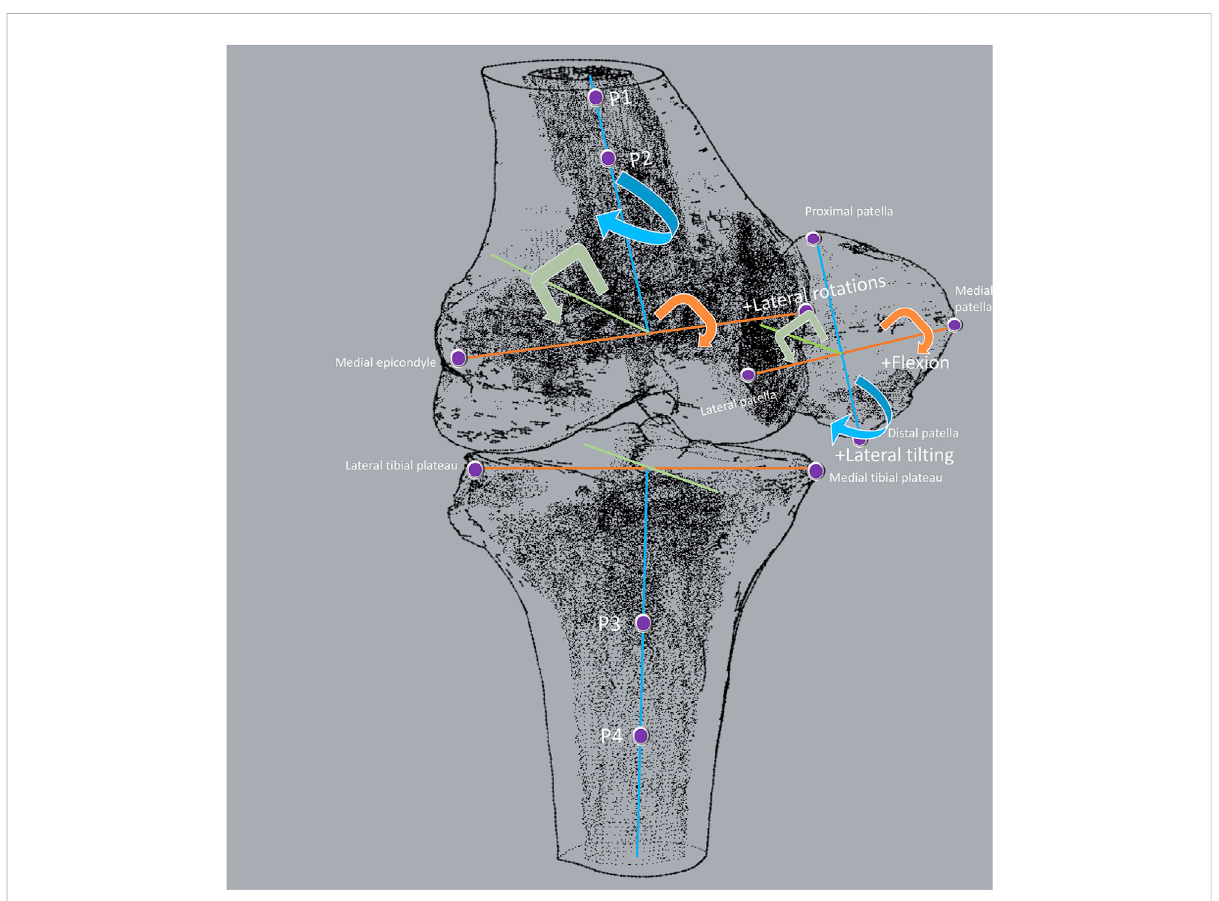
FIGURE 1 De fi nition of patellofemoral and tibiofemoral coordinate systems. The “ 4-points ” method was employed to build coordinate systems in the femur, patella, and tibia. In the femur, the fi rst two points were the prominent points of the medial and lateral femoral epicondyles. The other two points formed a line parallel to the sides of the femur shaft. In the patella, the fi rst two points were the most medial and lateral points on the patella. The other two points were the most proximal and distal points on the patella. The line connected to the most medial and lateral points on the patellawasde fi nedasthemedial-lateralaxis,andthemidpointofthislinewasde fi nedastheoriginofthepatella.Inthetibia,the fi rsttwopointswere the most external points on the sides of the medial and lateral tibia plateau. The other two points formed a line parallel to the sides of the tibia shaft. PFJ kinematics was the movement of patella relative to the middle point of the prominent points of the medial and lateral femoral epicondyles, including patellar fl exion/extension, varus/valgus, medial/lateral tilt, anteroposterior translation, medial/lateral translation, and proximal/distal translation. TFJ kinematics was the movement of tibia relative to the middle point of the most external points on the sides of the medial and lateral tibia plateau, including tibial fl exion/extension, varus/valgus, medial/lateral rotation, anterior/posterior translation, distal/proximal